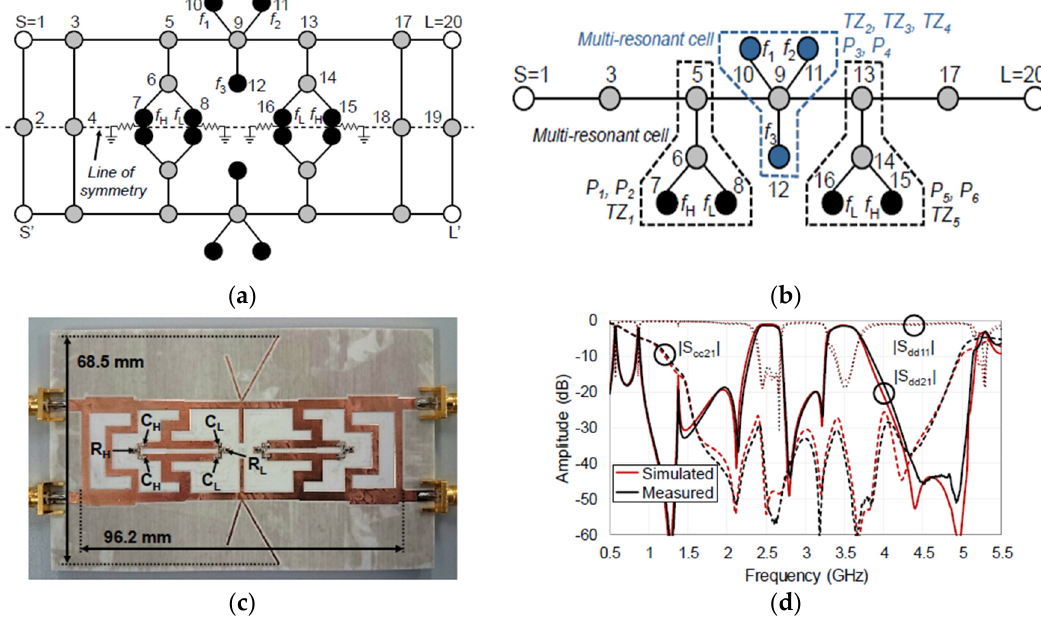
Figure 11. The proposed balanced dual-band BPF [65]: ( a ) Coupling scheme of the proposed filter; ( b ) Differential-mode single-ended coupling scheme; ( c ) Photograph of the fabricated prototype; ( d ) Simulated and measured frequency responses. Table 2. Performance comparisons for some recent dual-band differential microstrip BPFs.